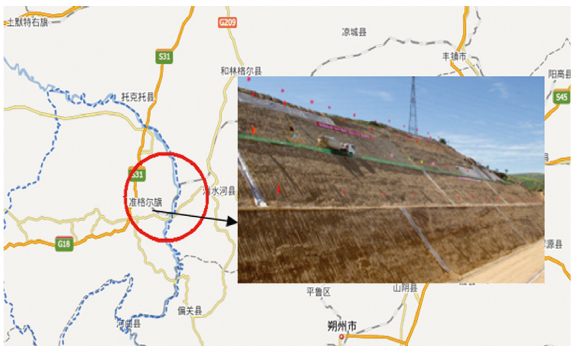
Figure 1: Engineering field figure.